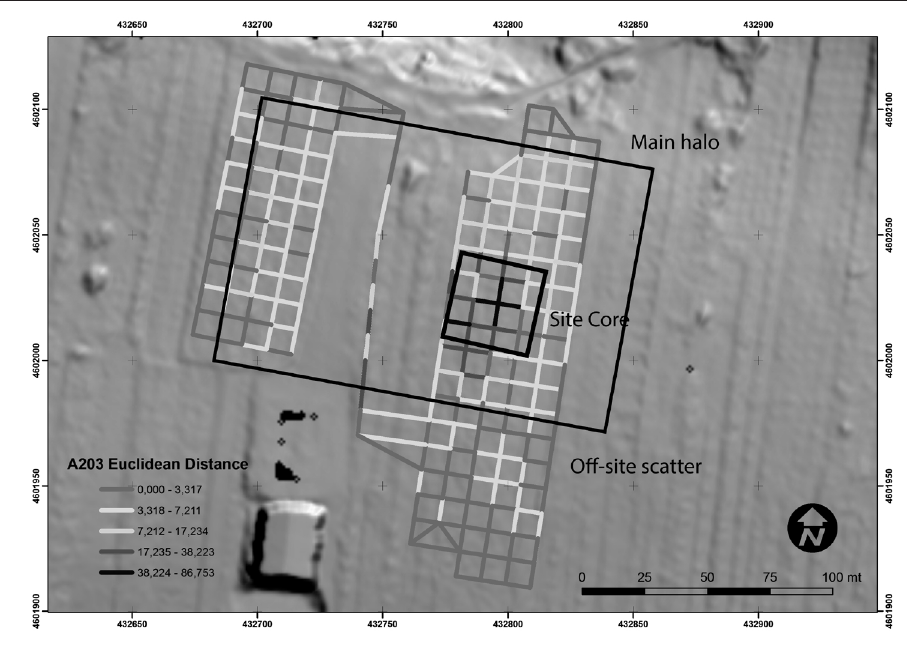
Figure 4: Euclidean distance analysis and interpretation in A203